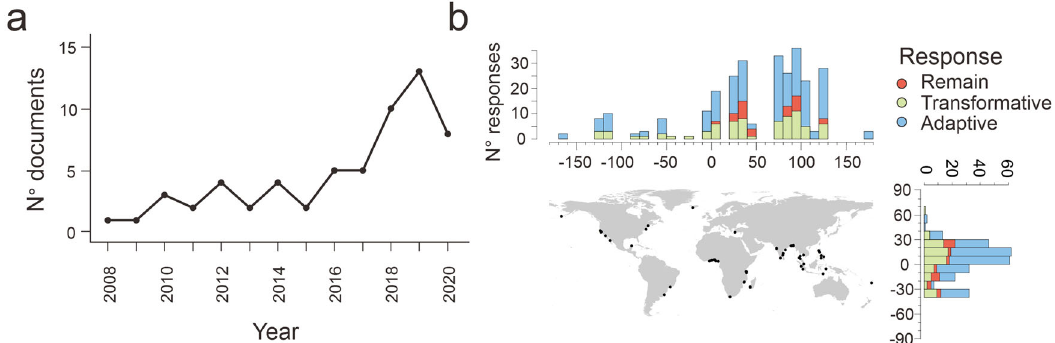
Fig. 1 Number of documents with climate change adaptations and location of small-scale fi shers ’ found in the literature. a Number of documents ( n = 60) reporting small-scale fi sheries responses to climate change by year of publication. Literature review conducted on July 2020. b Spatial distribution and corresponding latitudinal and longitudinal frequency histograms of the resulting reported responses ( n = 281) from small-scale fi shers to climate change reported in the literature by category. Map was created using ArcMap